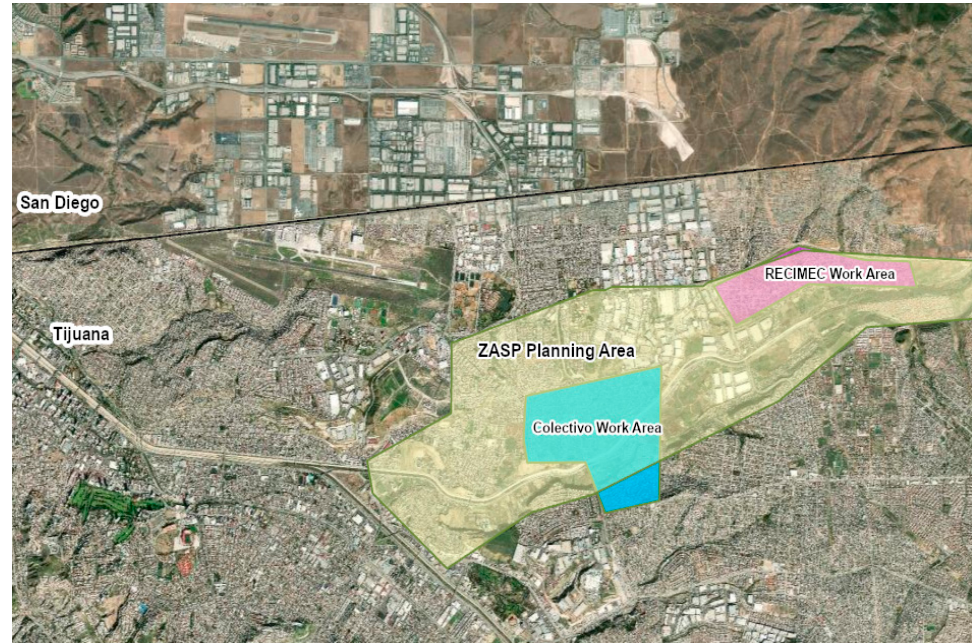
Figure 1. Zona Alamar Specific Plan (ZASP) Planning Area and Organization Work Areas.